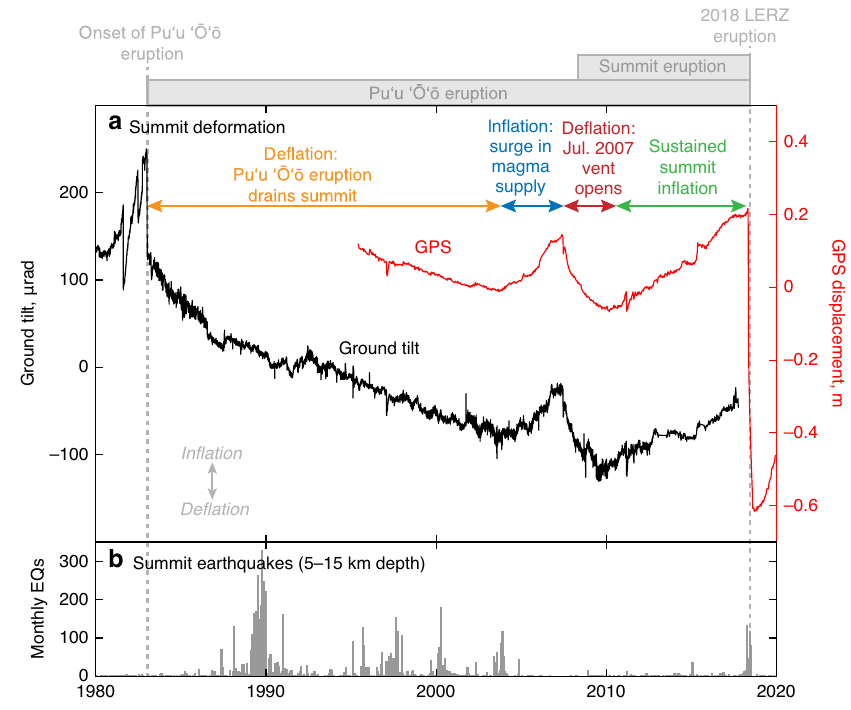
Fig. 2 Deformation and seismicity at K ī lauea ’ s summit, 1980 – 2020. a Summit deformation (UWT radial ground tilt and and UWEV northward GPS displacement) showing de fl ation of the summit reservoir following the onset of the Pu ʻ u ʻ Ō ʻ ō eruption, interrupted by several years of in fl ation due to a surge in magma supply from the mantle. From 2010 to early 2018, the summit experienced sustained in fl ation, terminated by the 2018 lower East Rift Zone (LERZ) eruption. b Located deep crustal earthquakes (magnitude 1.7 and greater) beneath the summit (5 – 15 km depth), showing lower crustal swarms in the 1980s and 1990s that were not associated with changes in eruptive